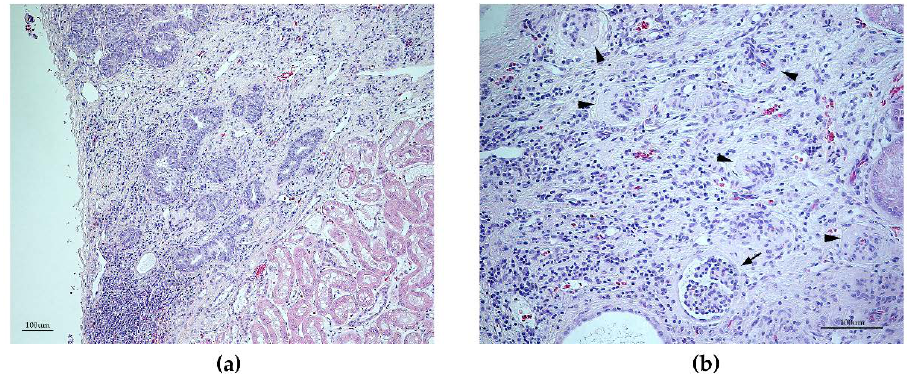
Figure 6. Renal histopathology of the affected male dog (GR01). Light microscopy of the right kidney stained with hematoxylin and eosin, showing a segmental area of fibrosis, ( a ) infiltrated by lymphocytes and plasma cells, extending from cortex, with the presence of a disarray of atypical tubular structures, and ( b ) with occasional small glomeruli with peripheral nuclei and inapparent capillaries (fetal glomeruli, marked with an arrow). Furthermore, multiple degenerated glomeruli are seen (arrowheads).